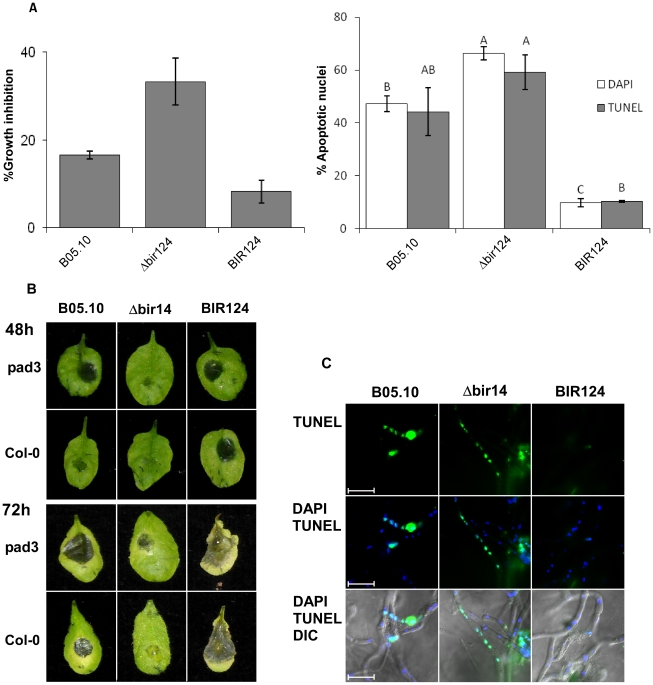
Camalexin induces PCD in B. cinerea and limits lesion spreading.(A) Growth inhibition and induction of PCD in B. cinerea by camalexin. Fungi were grown in PDB for 24 h and then camalexin was added at 15 µg/ml. A. Effects on growth (left graph) and PCD (right graph) were recorded after 48 h and 4 h, respectively. Growth assays were performed in triplicates. Apoptotic nuclei counts were determined by counting 200 nuclei per sample. Data represent mean ±SEM (n = 3). Columns not connected with the same letter are statistically different (p<0.05) as determined by one-way ANOVA (p<0.001) followed by a post-hoc Tukey HSD analysis. (B) Infection of camalexin-deficient pad3 mutant and Col-0 wild type plants by B. cinerea. Plants were inoculated with spore suspensions of B. cinerea B05.10, Δbir14 mutant and BIR24 over expression strains. (C) PCD was detected by TUNEL assay 48 h PI. Note that in this case the green nuclear signal denotes apoptotic nuclei. Bar  =  20 µm.